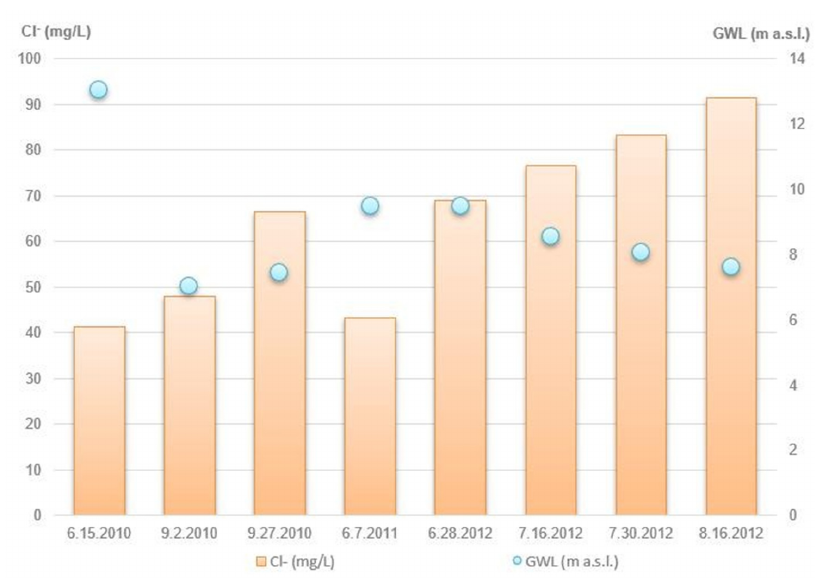
Figure 9. Chloride concentration and GWL data for boreholes at Korita from 2010 to 2012. The f sea was calculated using the chloride anion as a conservative (nonreactive) constituent of the mixture, as described in Section 3. The results are presented in Table 4. Table 4. Seawater percentage in spring and groundwater samples from Vis Island.